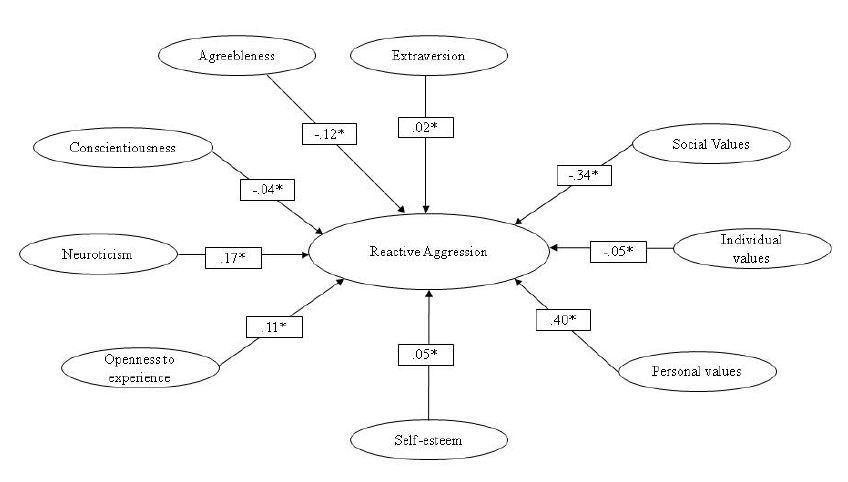
Figure 4. Structural equation model for reactive aggression (involvement) using personality, values, and self-esteem